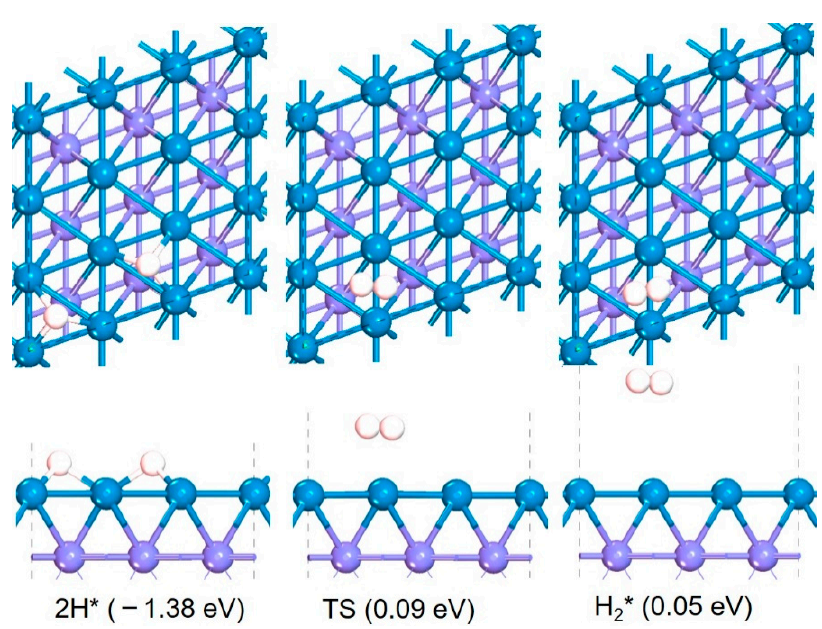
Figure 5. The structures and corresponding energy changes of H 2 formation on Fe (110).